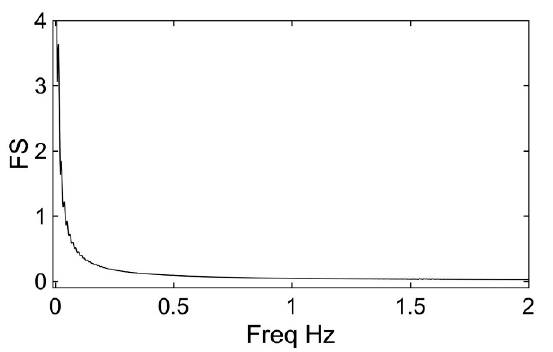
Figure 6. FFT of the plastic region of the tensile stress-time curve of the Al wires tested at 0.500 mm/min (3.33·10 –5 s –1 ).